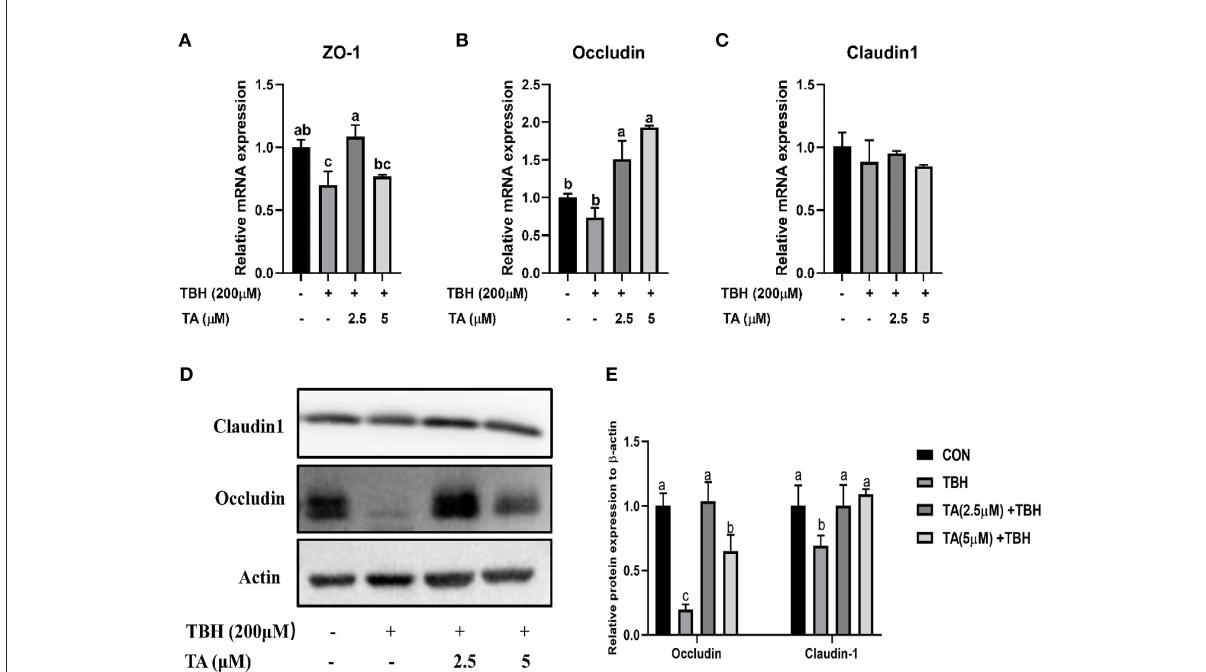
FIGURE7 Effects of tannic acid (TA) on the tight junction of IPEC-J2 cells. The mRNA expression of ZO-1 (A) , Occludin (B) , and Claudin-1 (C) . Western blotting analysis of the protein expression of Occludin and Claudin-1 is shown (D) . Quantitative analysis of the protein expression of Occludin and Claudin-1 (E) . Data are presented as mean ± SEM, n = 3. TA, tannic acid; TBH, tert-butyl hydroperoxide. a,b values in the same row not sharing a common superscript differ significantly.